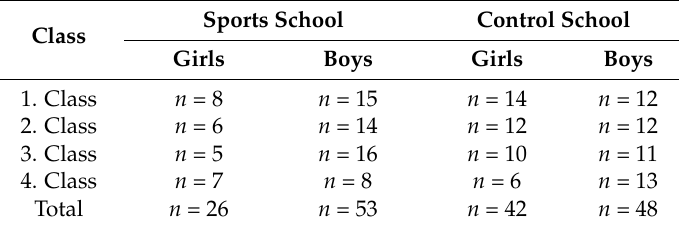
Table 1. Numbers of girls and boys participating at the